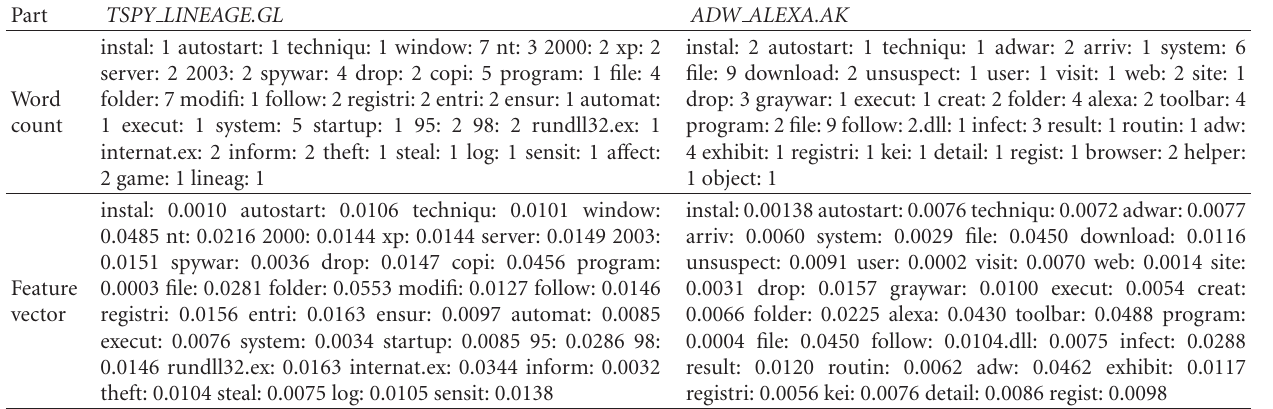
Table 3: Feature vectors for spyware TSPY LINEAGE.GL and adware ADW